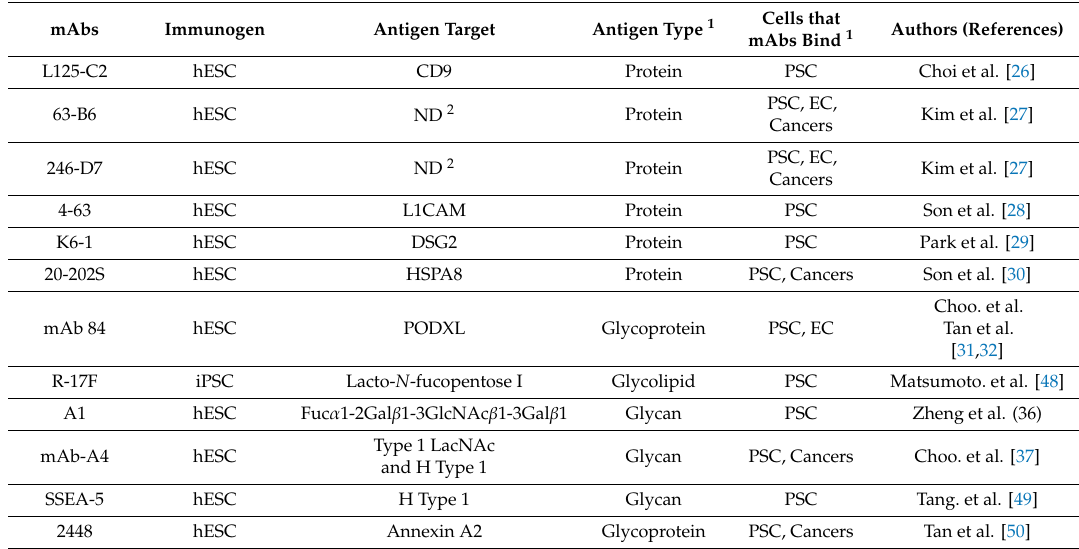
Table 1. Summary of mAbs generated against PSCs and used for regenerative cell